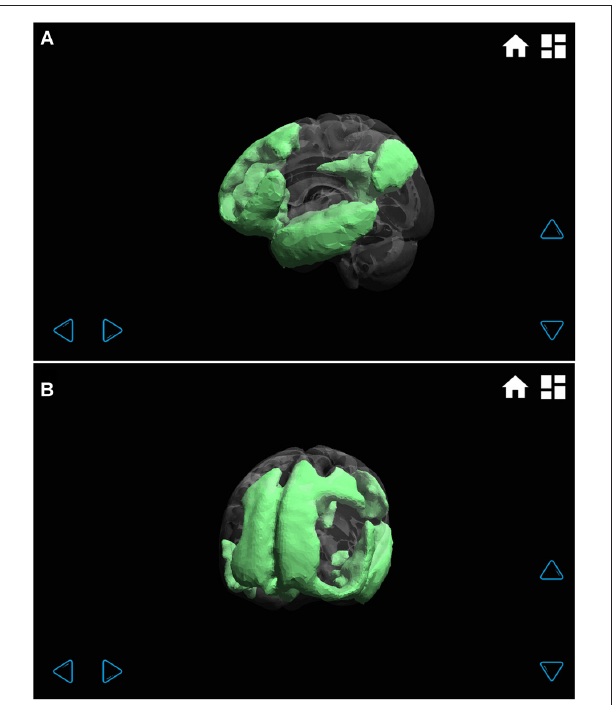
FIGURE 5 | Default mode functional connectivity network displayed at different angles (A left hemisphere, and B left frontal). Through the transparent brain, the different regions that make up this wide network can be clearly seen: mainly frontal, parietal and temporal lobe